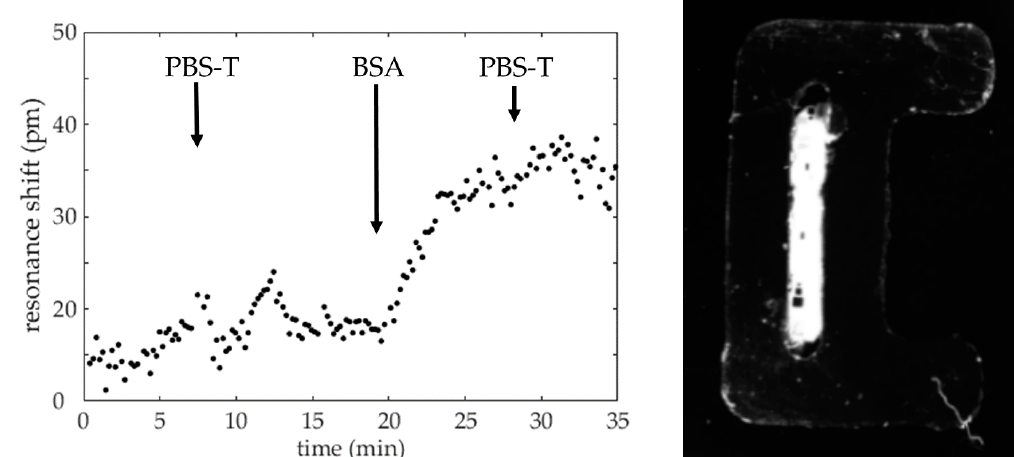
Figure 6. ( Left ) Temporal evolution of the PBG spectral shift during the BSA detection experiment. ( Right ) Fluorescence test was carried out after binding a fluorophore-labelled secondary aBSA antibody to the recognized BSA